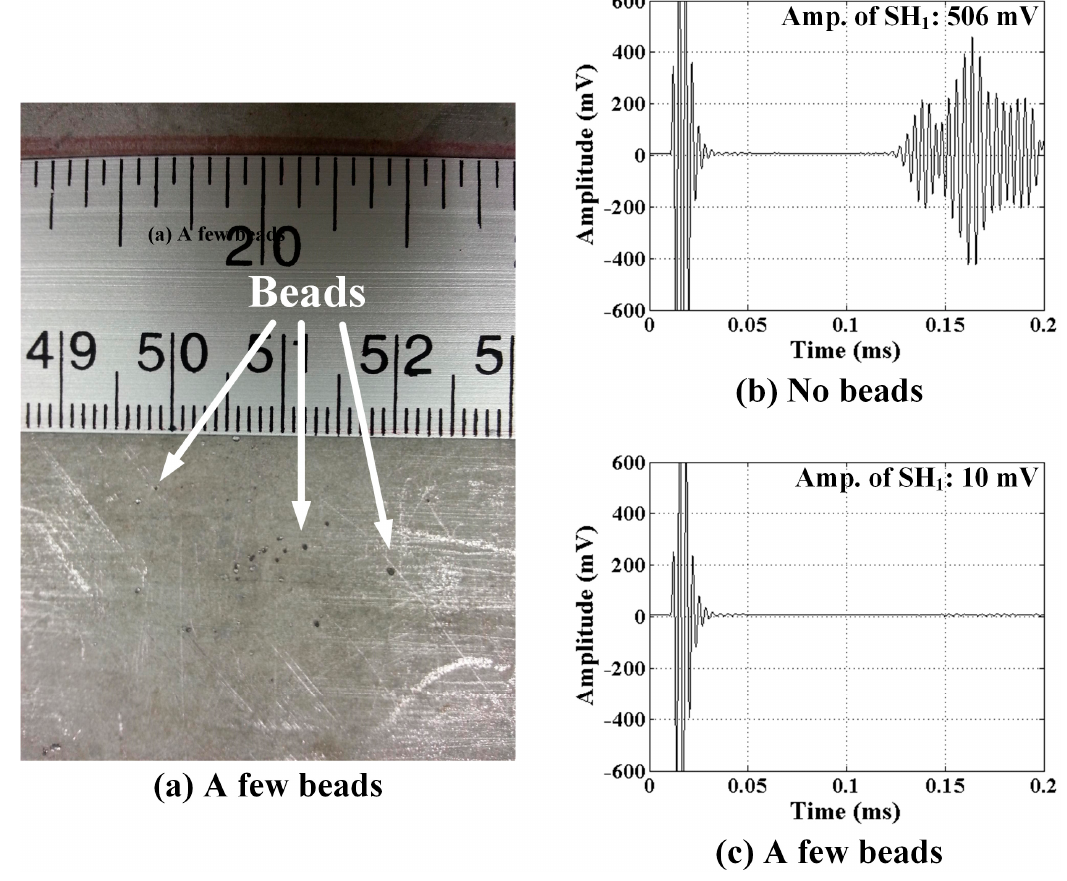
Figure 12. ( a ) Distribution of a few glass beads between the MST receiver and the substrate; and SH wave signals received for: ( b ) no beads; and ( c ) a few beads.